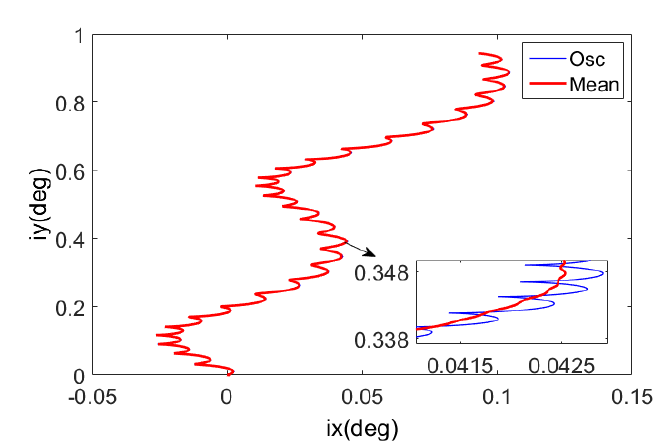
Figure 3. Mean orbital inclination vector under the influence of the semi-monthly period term.